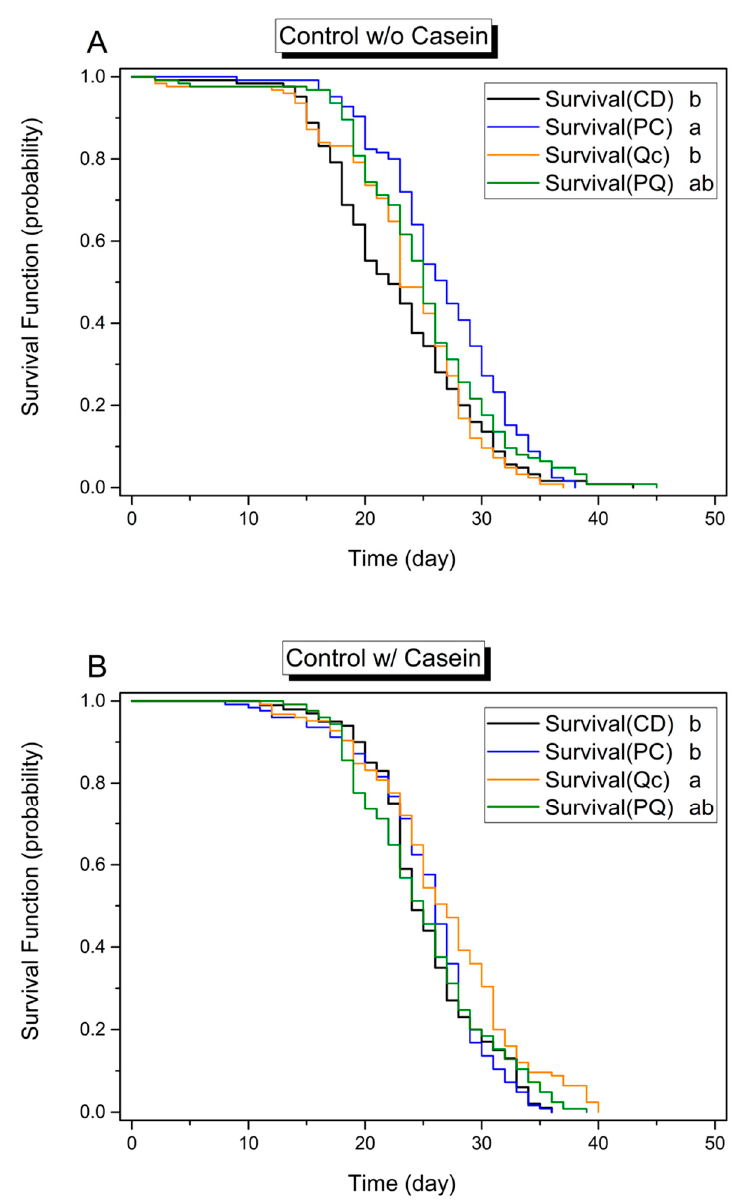
Figure 1. Kaplan–Meier plot of honey bee survival function on different diets with different phytochemical supplements. These diets were ( A ) protein-free or ( B ) protein-supplemented. CD, diet lacking phytochemicals; PC, diet containing 0.5 mM p -coumaric acid; Qc, diet containing 0.25 mM quercetin; PQ, diet containing 0.5 mM p -coumaric acid and 0.25 mM quercetin. ( n = 100 for protein-rich and phytochemical-free diet group (CD in Figure 1B), and n = 125 for the other groups.) Different lower-case letters indicate statistical differences between treatments (log-rank paired test, p < 0.0083 after Bonferroni